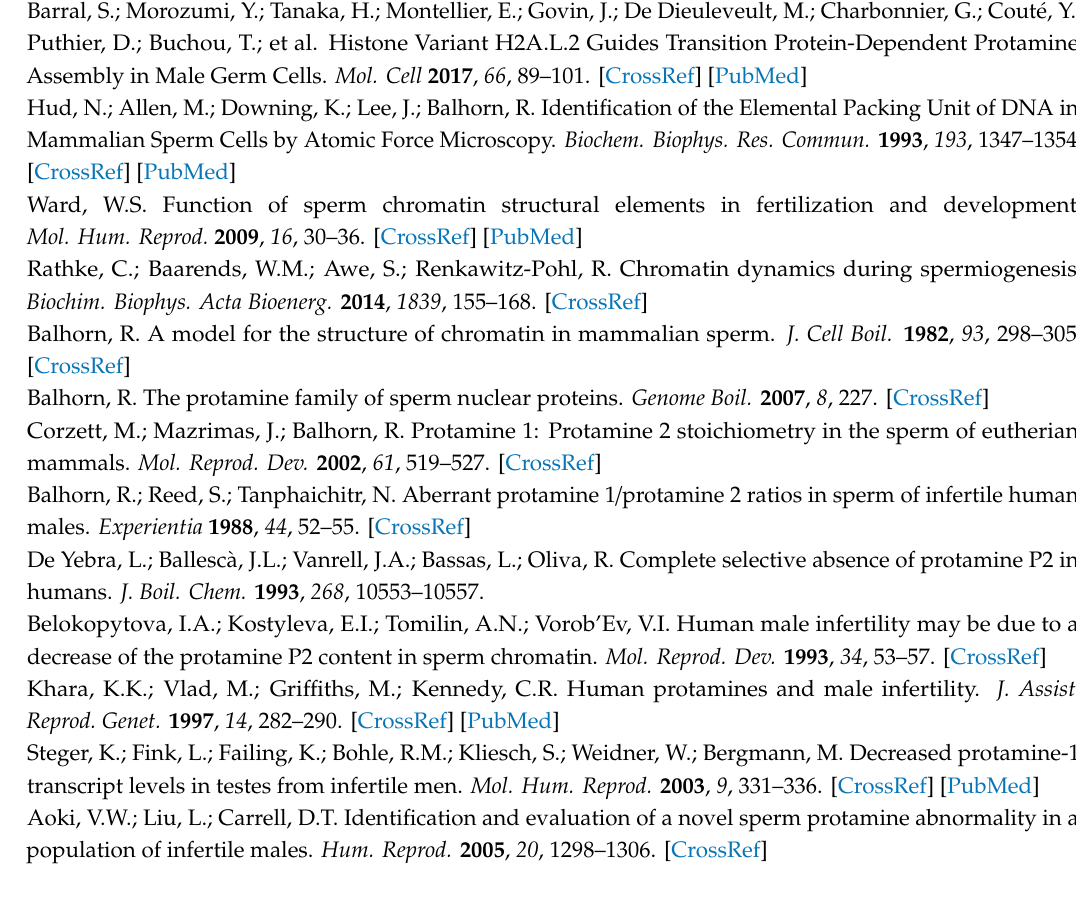
Figure S1: Membrane integrity and sperm viability are decreased in Prm2 -deficient mice; Figure S2: Normalization and quality controls of MS data; Figure S3: Profile Plot PRDX5; Figure S4: Prm2 -deficient epididymal sperm display a decreased head size; Figure S5: Analyses on DE genes identified by RNAseq of Prm2 -deficient testes